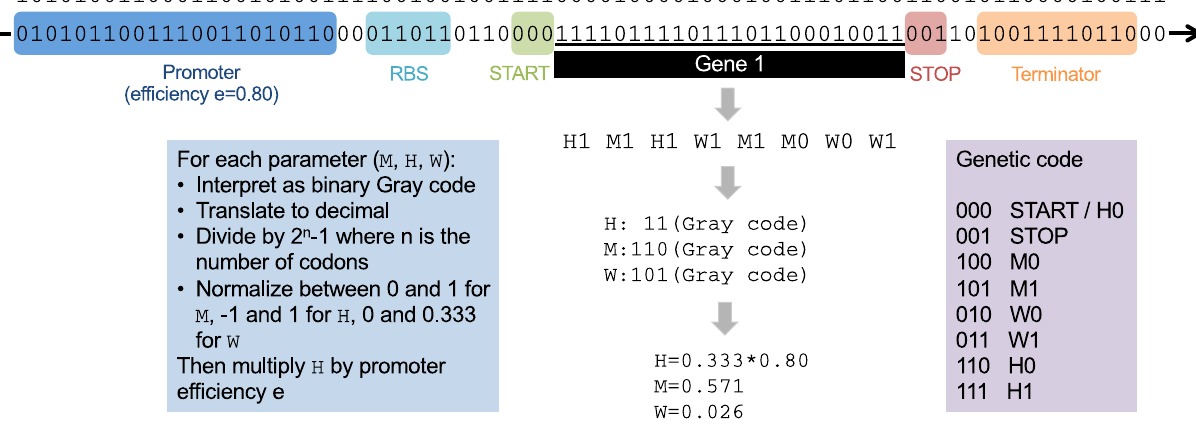
Figure 6. Aevol genetic code. Here we use an example of a functioning gene from an Aevol individual to explain the transcription and the translation processes. The gene is flanked by a promoter and terminator regions and preceded by a ribosome binding site (RBS). The codons for mean position, the width, and the height of the protein are identified, transformed into Gray code using the Genetic code table (box on the right), and finally scaled and normalized, as we summarize in the box on the left and describe in more detail in the Methods. Note that a gene with re- shuffled codons, for example H1 H1 M1 M1 M0 W1 W0 W1, would encode exactly the same protein. START codon may occasionally be found inside a gene, in which case it is interpreted as H0. The promoter differs from the consensus sequence by 1 base out of the maximal 4 differences allowed, giving it a 0 : 80 efficiency.